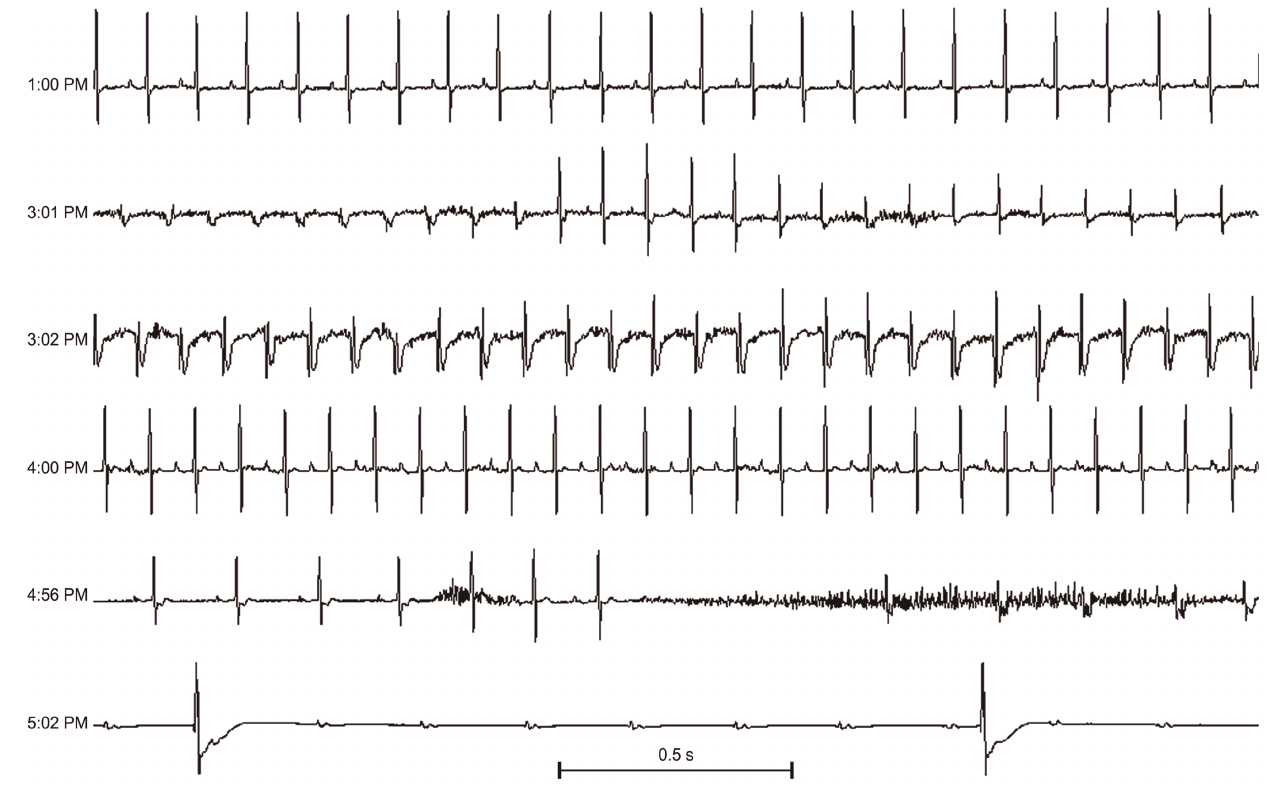
Figure 5. Recurrent LPS and arrhythmias prior to death. Telemetry tracings from a mouse that died 39 days after weekly LPS 10 mg/kg i.p. Each strip is 2.5 seconds. The mouse was in sinus rhythm 552 beats per minute (bpm) at baseline at 1:00 p.m. Two hours later, an accelerated idioventricular rhythm (AIVR) or slow ventricular tachycardia (VT) with fusion complexes with sinus beats developed (3:01 pm), with an AIVR or slow VT at 648 bpm at 3:02 pm. The mouse returned to sinus rhythm at 625 bpm at 4:00 pm. One hour later, there was sinus exit block with slow idioventricular escape rhythm (4:56 pm), and then high degree AV block (5:02 pm) shortly before death.